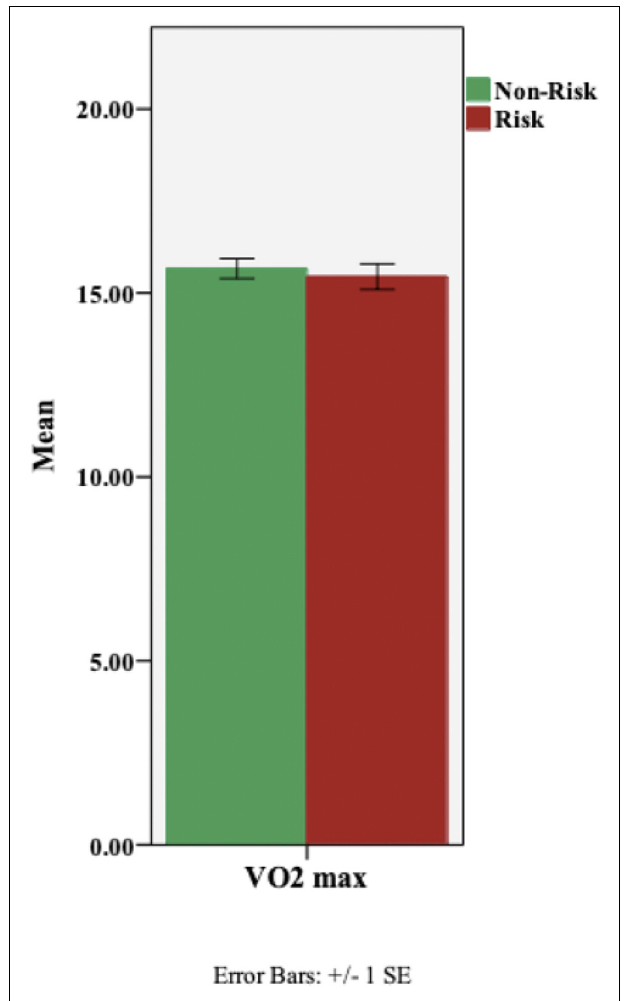
FIGURE 3 | Aerobic fitness (VO 2 max) based on ABCA7 genotype: Non-Risk (TT) vs. Risk (GG). There was no effect of genotypic group on VO 2 max (p =